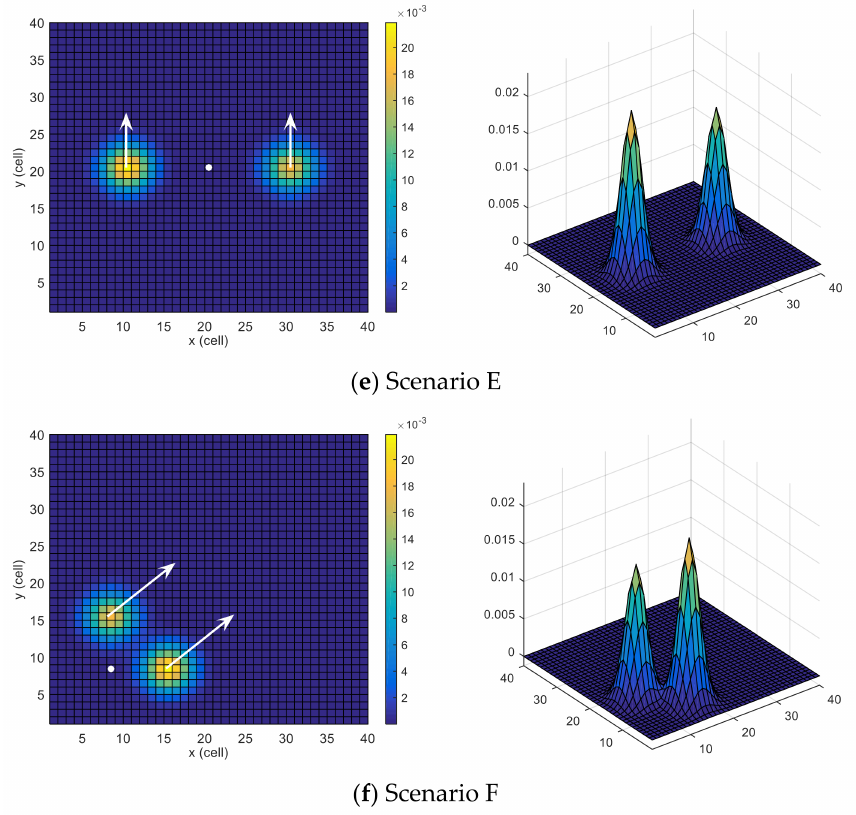
Figure 3. Search